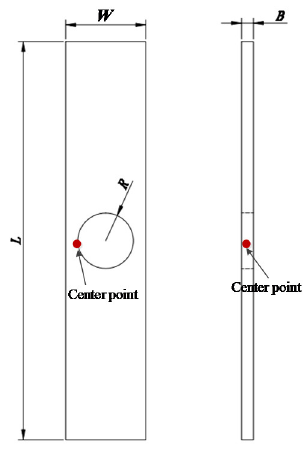
Figure 2. CHS specimen [31].